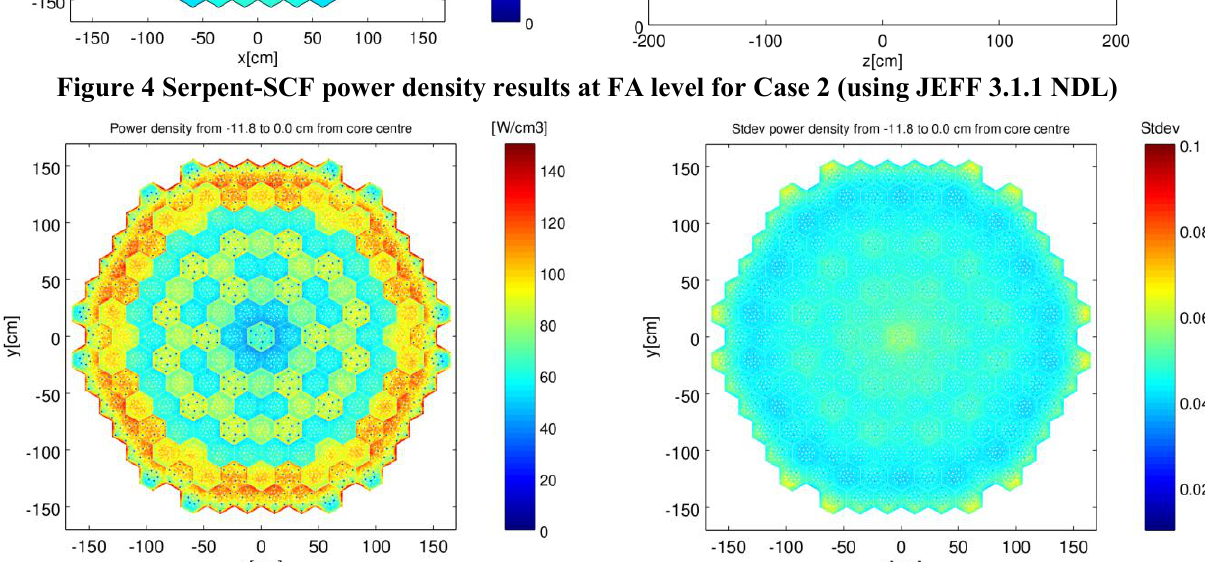
Figure 4 Serpent-SCF power density results at FA level for Case 2 (using JEFF 3.1.1 NDL)